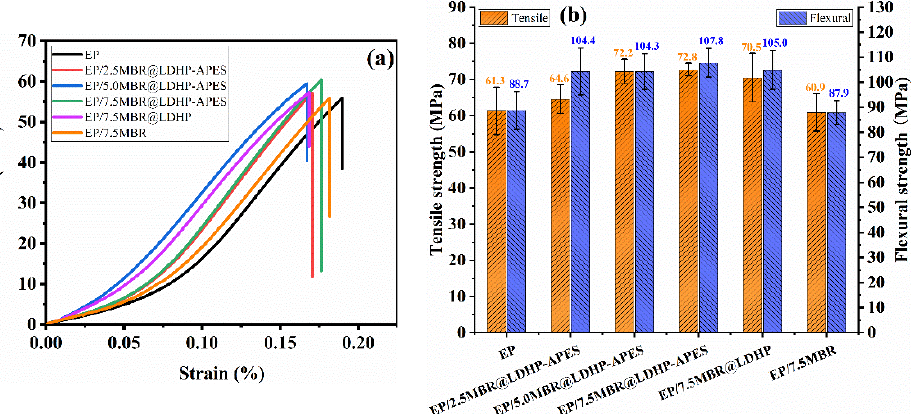
Figure 6. Tensile stress-strain curves ( a ) and tensile and flexural strength ( b ) of pure EP and its composites.